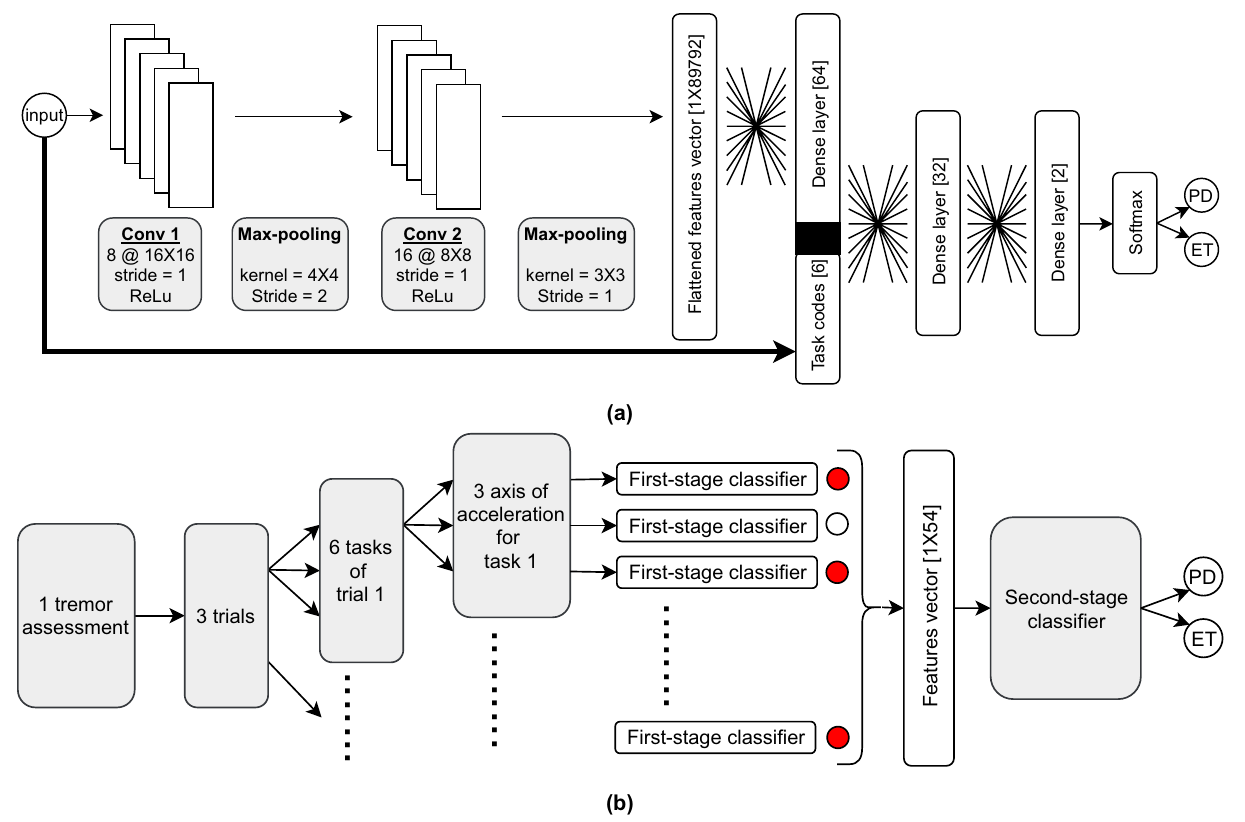
Figure 3. The overall processing framework of NeurDNet to perform differential diagnosis between PD and ET. ( a ) This part depicts the processing pipeline for the first-stage classifier, which is based on convolutional neural networks. In this stage, a preliminary decision (PD or ET) is made on a single signal of tremor assessment, which is previously passed through the pre-processing block. This signal could be the acceleration of hand motion in any axis, from any task of any trial. ( b ) This figure shows the second stage of the classification process for each tremor assessment. In fact, each tremor assessment contains 54 tremor signals, where all of them are passed through the first-stage classifier. Then, the decision on each signal is aggregated in a vector of length 54 which forms the feature vector for the second-stage